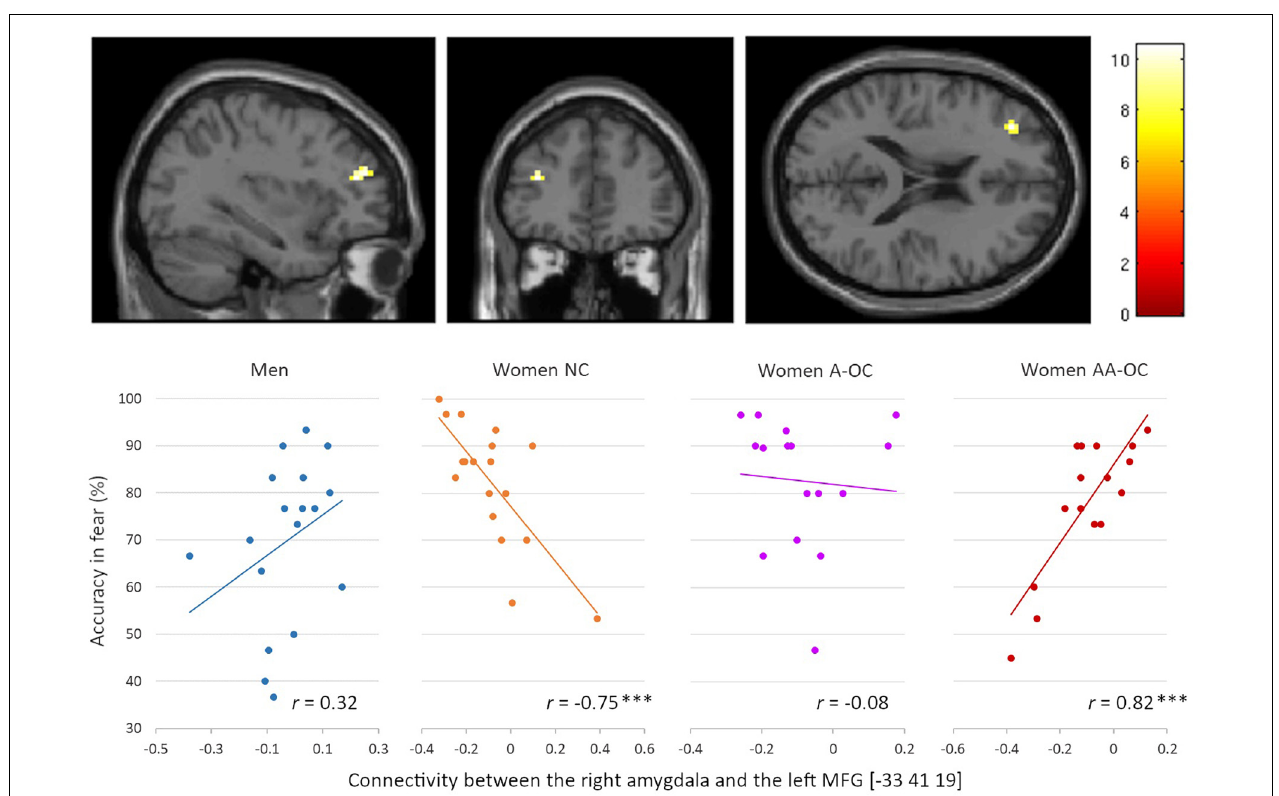
FIGURE 6 | Relationship between the right amygdala-left middle frontal gyrus connectivity and accuracy for fearful faces by group. Connectivity strength and accuracy were found to be negatively correlated for naturally cycling women, whereas they were positively correlated for women on anti-androgenic oral contraceptives. *** p < 0.001.